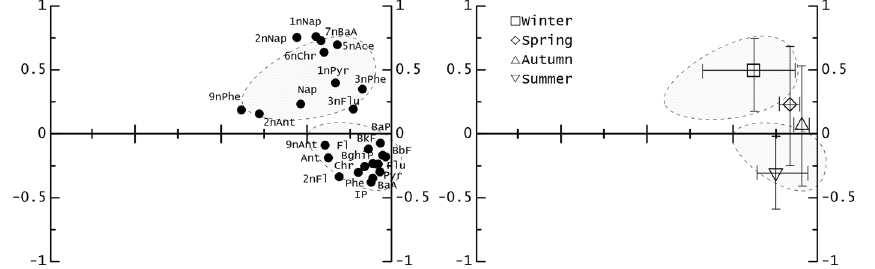
Figure 2. PCA loadings (left) and scores (right) plots for the first two components of all PAHs in PM2.5 from 9 urban